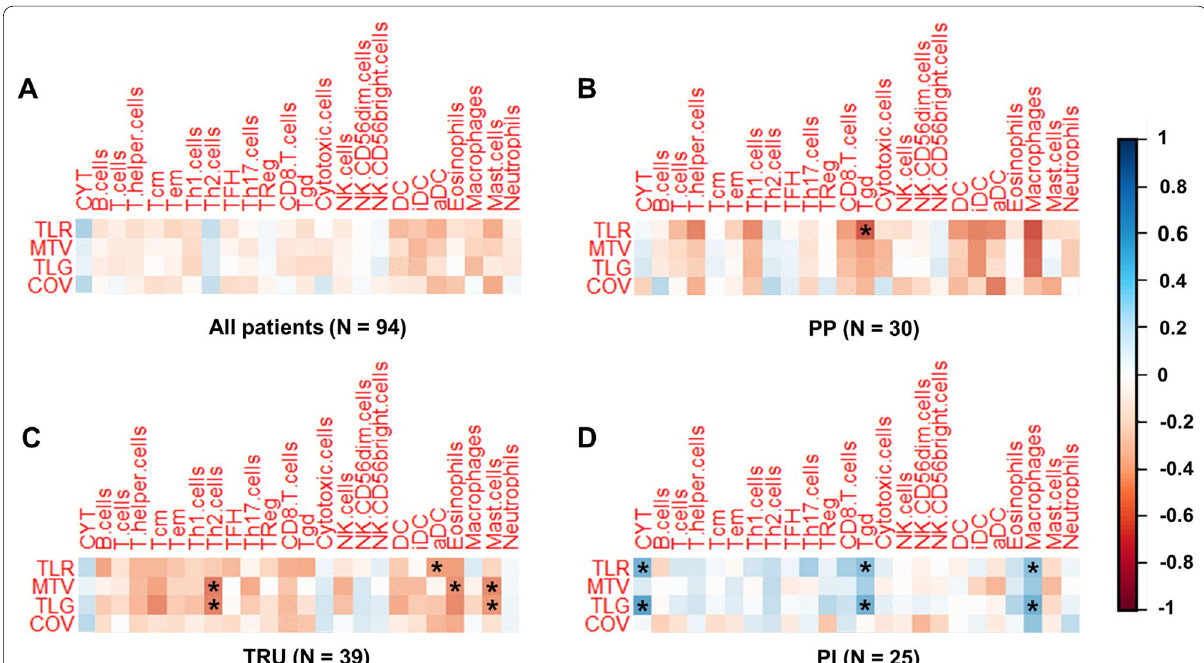
Fig. 3 Correlation map of 18 F‑FDG parameters and immune cell scores in all patients and each molecular subtype. Correlation coefficients ( r ) are expressed using a color scale. An asterisk means a pair for which | r |> 0.4 and P < 0.05. This result has not corrected for multiple testing. A correlation map of 18 F‑FDG parameters and immune cell scores in all patients, B – D correlation map of 18 F‑FDG parameters and immune cell scores in PP, TRU and PI group